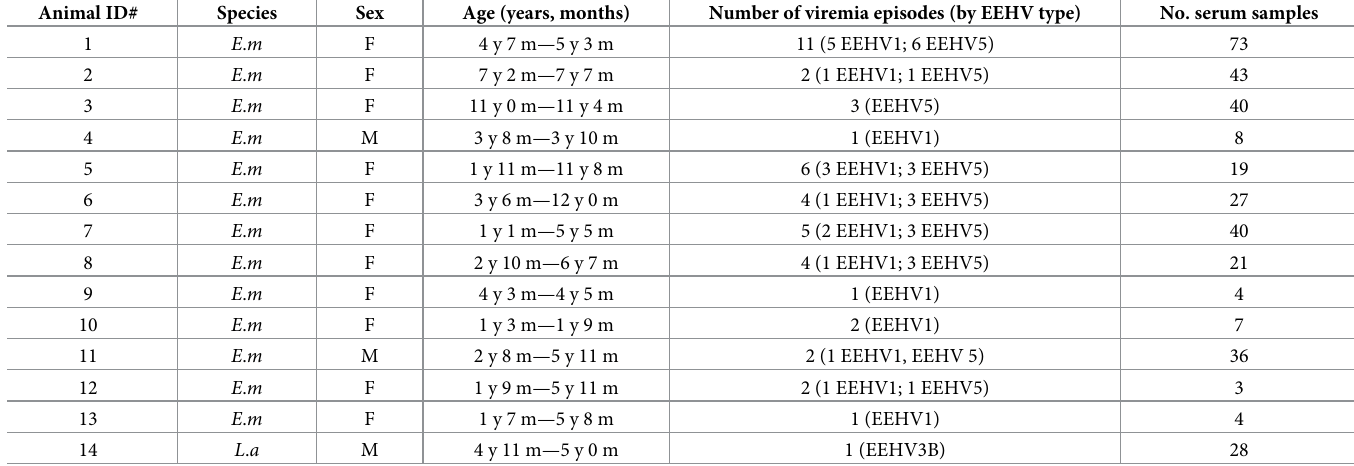
Table 1. Subjects and serum samples included in the study. The age range incorporates the period of sample collection and may encompass multiple viremia episodes over the study period. Animal